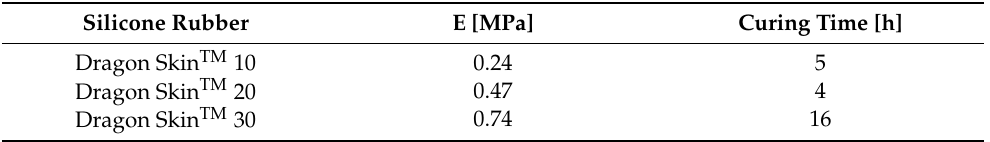
Table 1. Dragon Skin TM silicone rubber